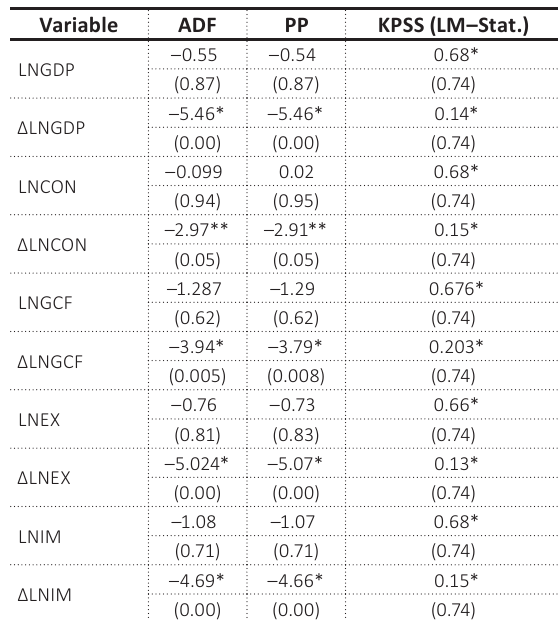
Table 3. Co-integration test results